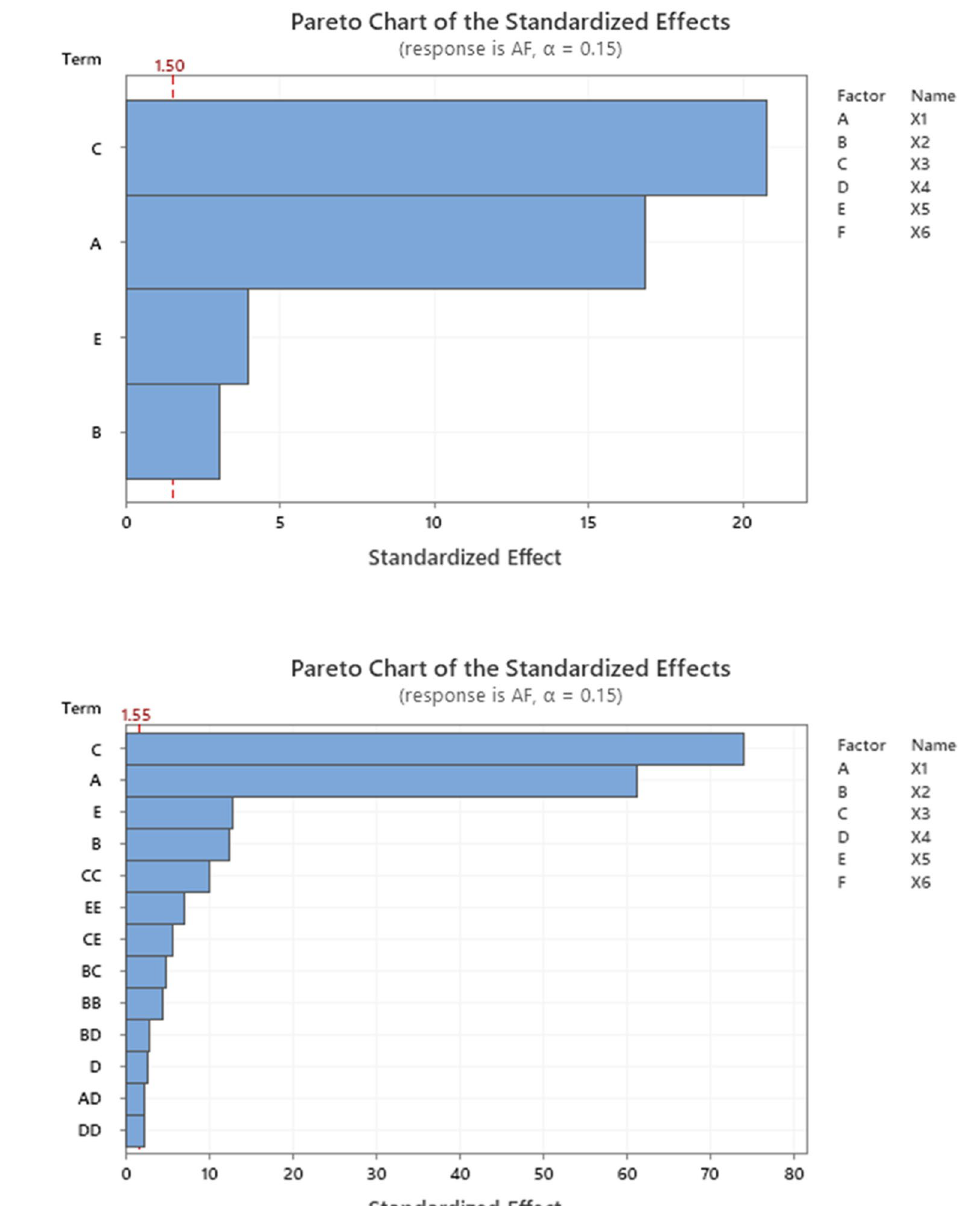
Fig. 9 Pareto chart of stand- ardized effects for SWLR of AF (only for terms which P value < 0.05. Here 1.50 is